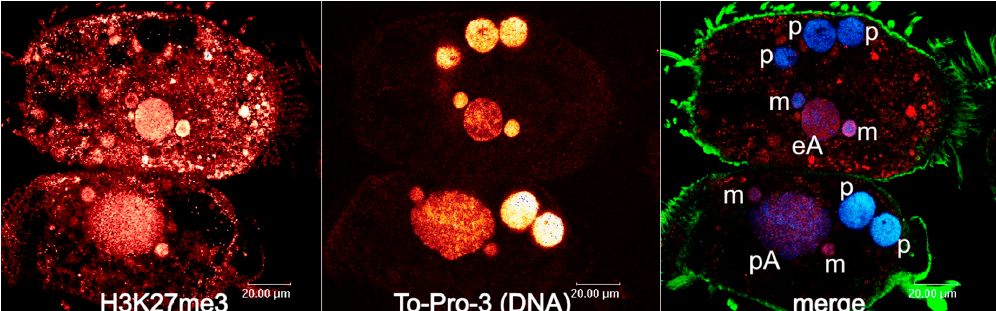
Figure 1. Two Stylonychia cells with developing macronuclei at an earlier stage of chromosome polytenization (upper cell) and at a stage of maximum polytenization (cell below). Left: H3K27me3; centre: To-Pro-3 counterstaining of DNA; right: merge (red: H3K27me3, blue: DNA, green: alpha-tubulin). H3K27me3 exhibits strong signals in micronuclei and developing macronuclei in both successive developmental stages, whereas cytoplasmic enrichment is more obvious throughout the earlier stages of chromosome polytenization. This might be indicative of cytoplasmic post-translational histone H3K27me3 modification taking place prior to its specific chromatin deposition.